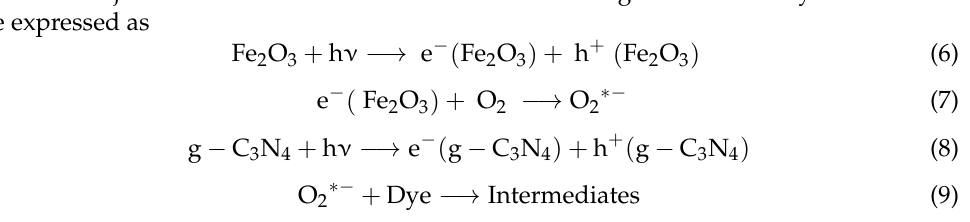
Figure 8. Possible band gaps calculated for ( a ) g-C3N4 and ( b ) Fe 2 O 3 precursors. Table 1. Band gap values calculated for g-C 3 N 4 and Fe 2 O 3 semiconducting materials.